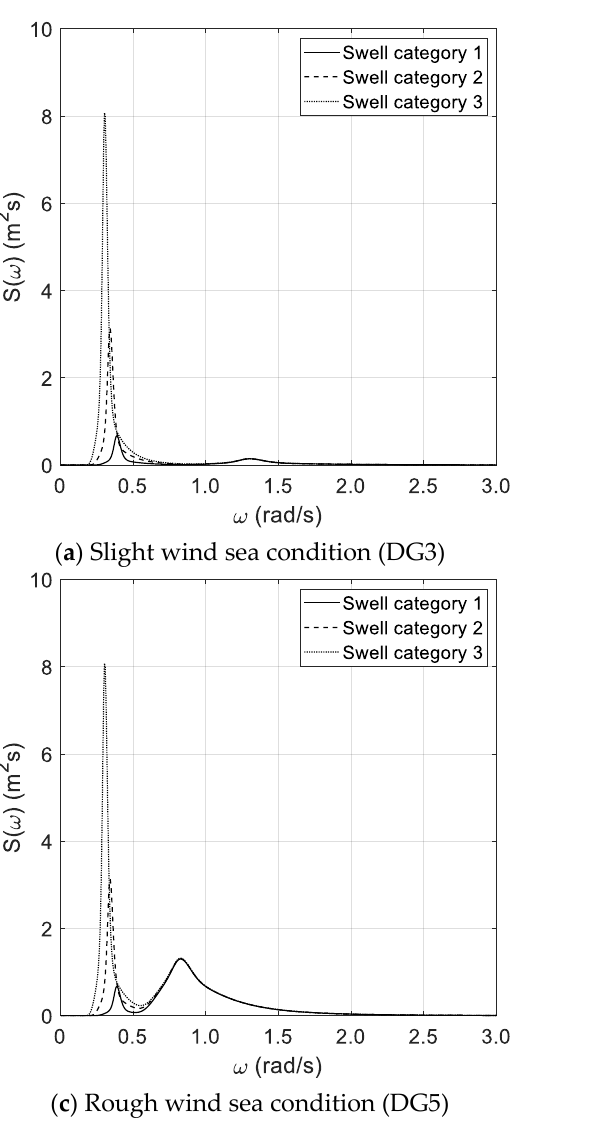
Figure 1. Reference sea state conditions.